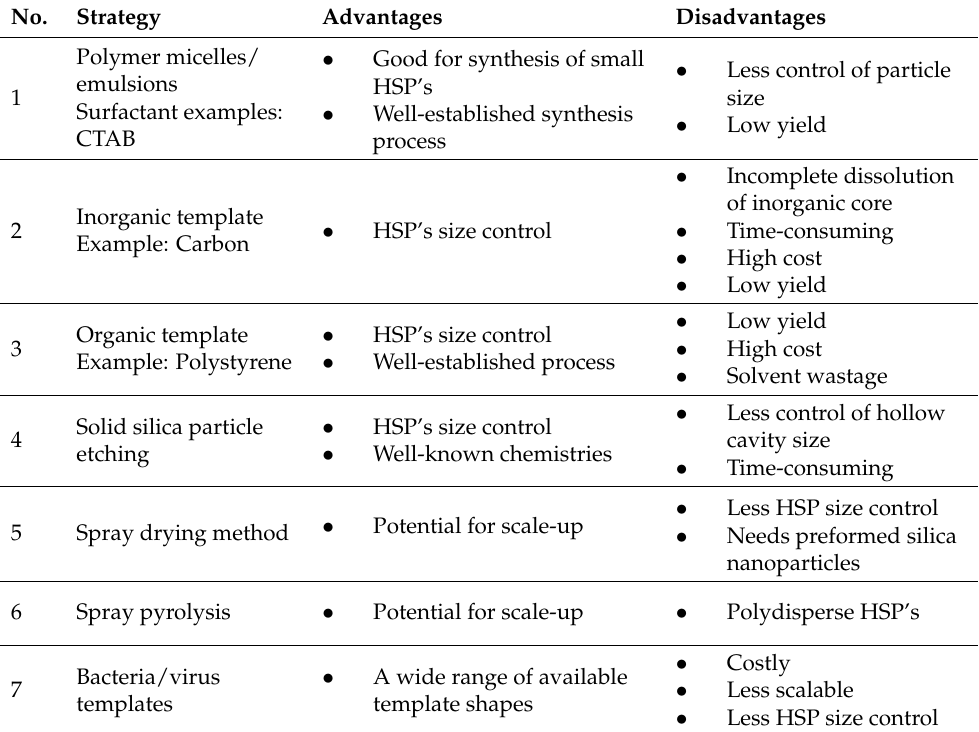
Table 1. Comparison of the various methods of synthesising hollow silica nanoparticles